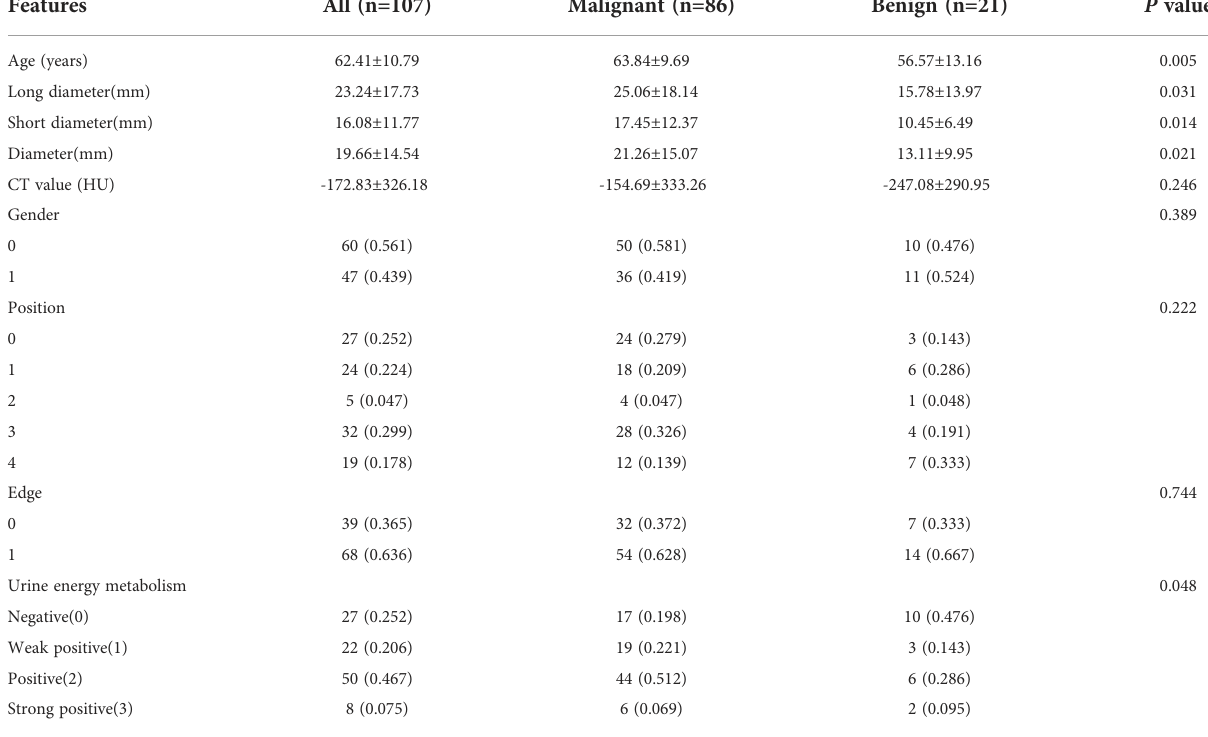
TABLE 1 Baseline clinical characteristics of patients in our cohort.